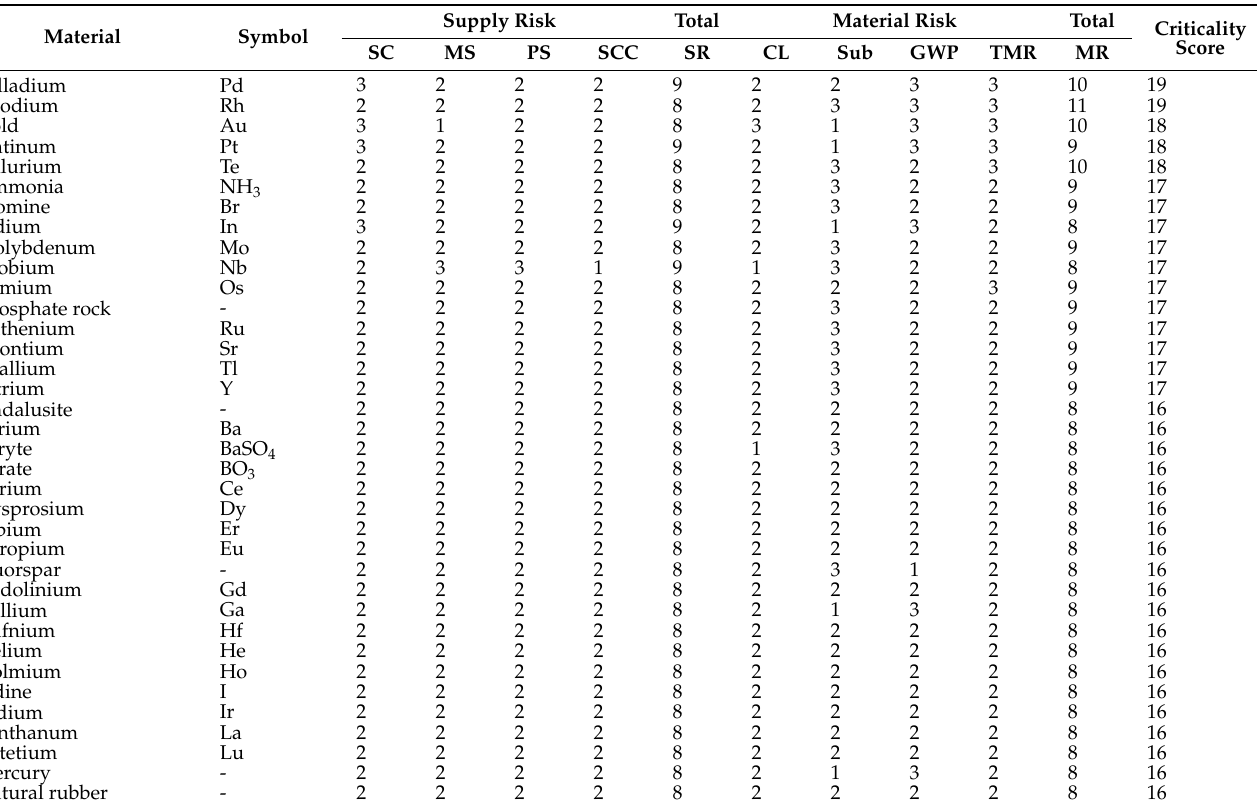
Table A1. The full list of 89 critical materials for